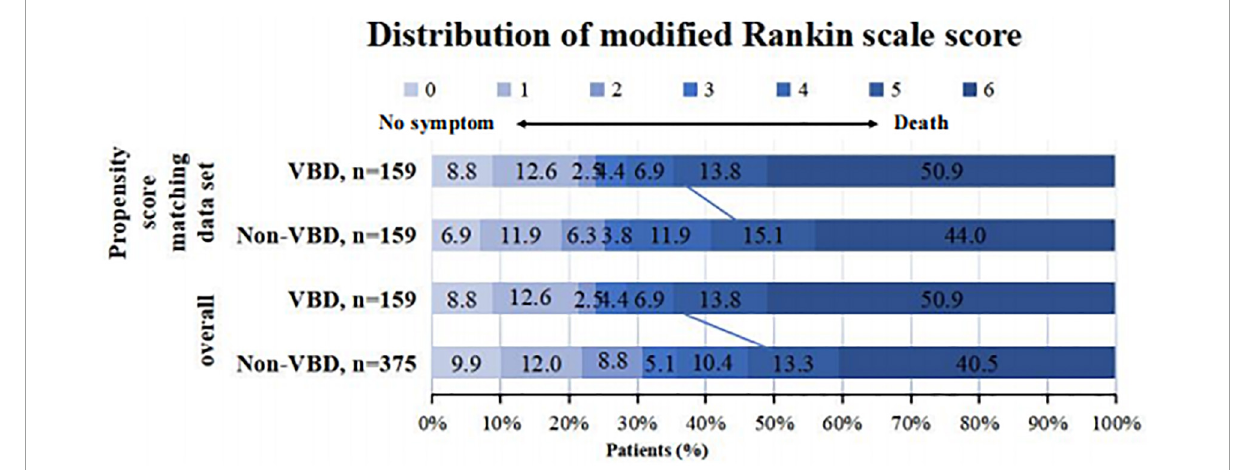
FIGURE1 Distribution of the modified Rankin scale score at 90 days in the VBD and Non-VBD.